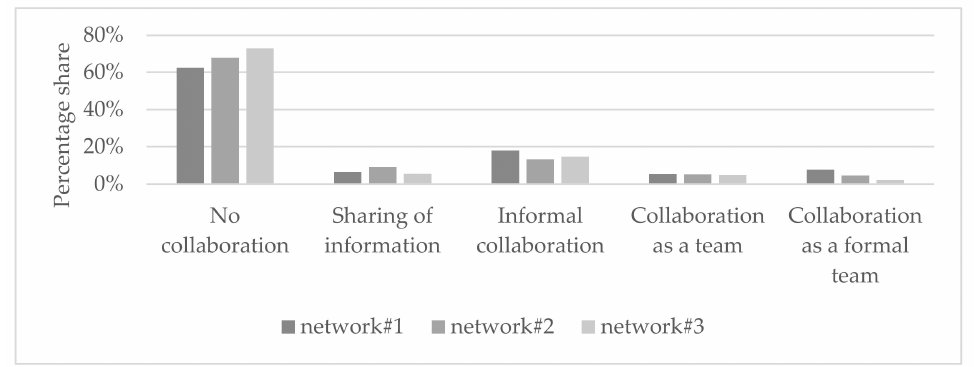
Figure 4. Distribution of collaboration intensity for all